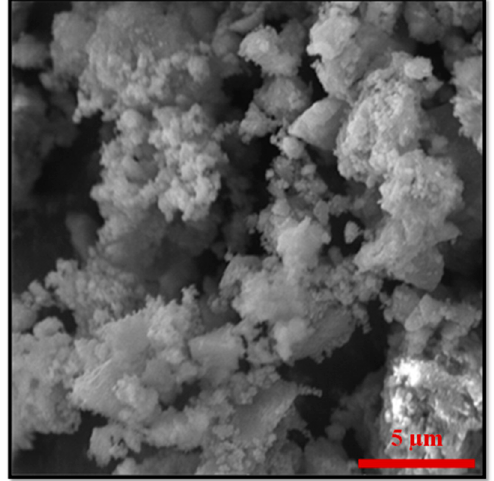
Figure 4. Additional, higher resolution SEM image for the sample ZF(acac) MMOF.